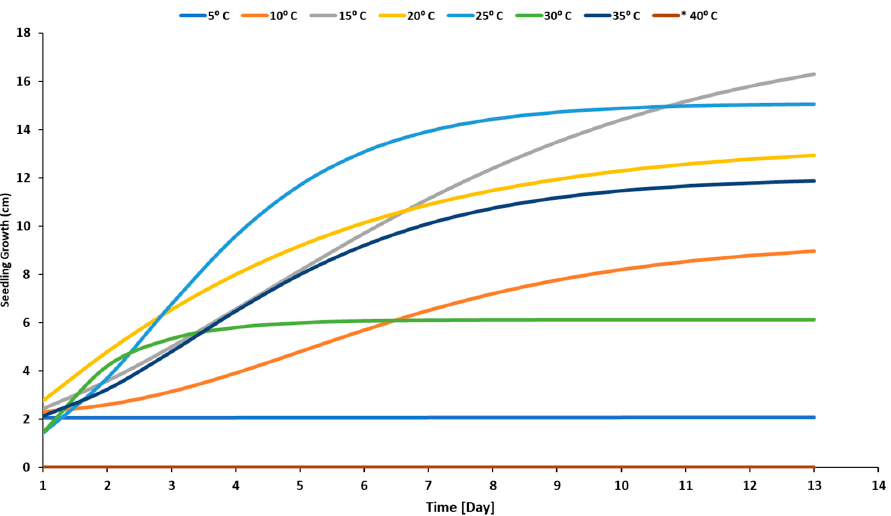
Figure 5. Effect of temperature levels on seedling growth response. The * represents 40 °C which is not shown on the graph because its value is zero (no seedling growth).